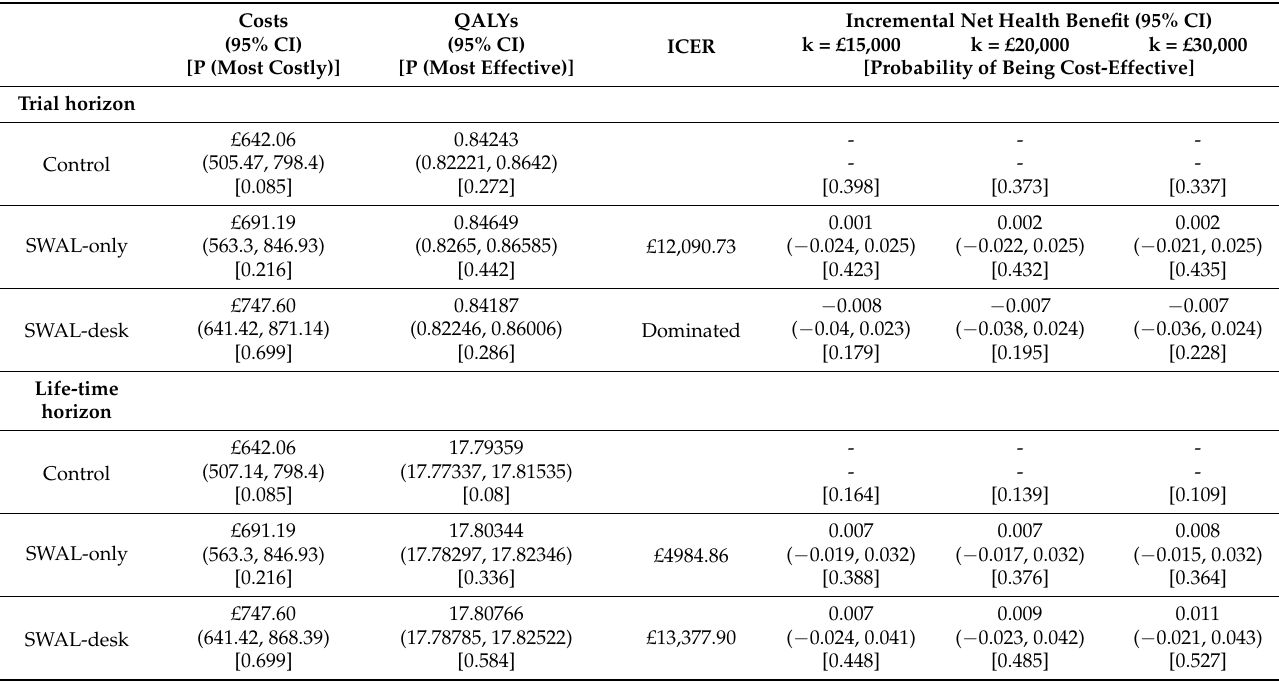
Table 1. Base case within-trial and lifetime cost-effectiveness results.